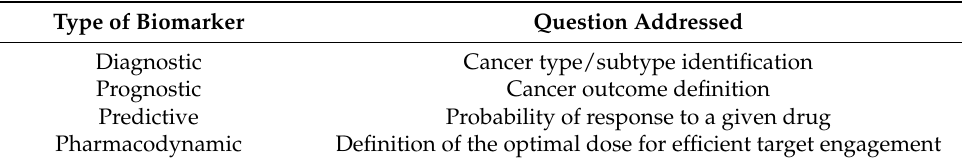
Table 1. Biomarker